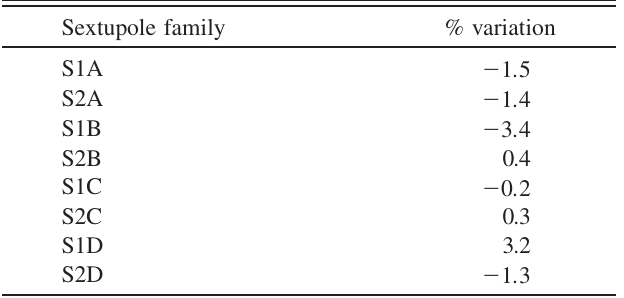
TABLE I. Relative variation of the sextupole strengths after the fit.